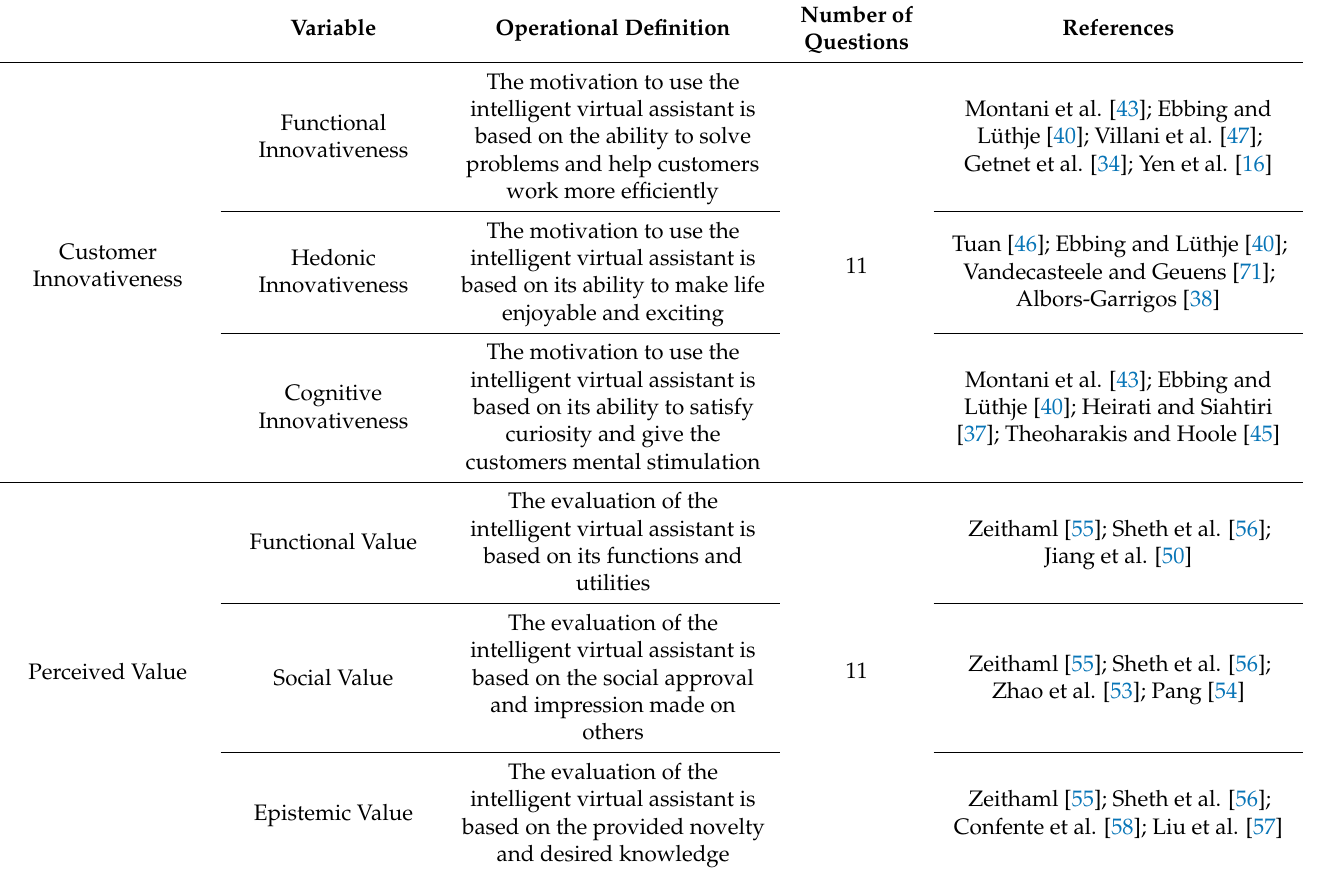
Table 1. Operational definitions of each dimension.